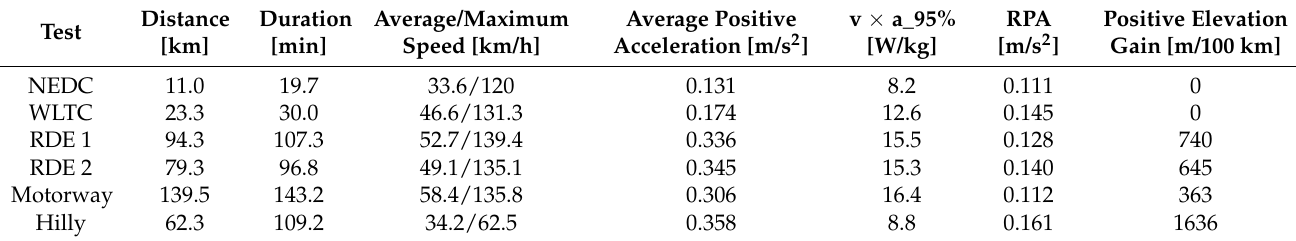
Table 2. Characteristics of the tested driving